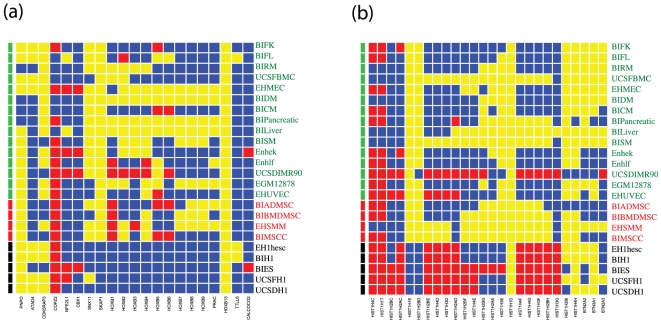
Representative chromatin domains identified by the hidden Markov model.Heatmap of the chromatin state distribution at the local genomic loci. (a) the HOXB gene cluster; (b) The histone gene cluster. Genes are ordered according to their genomic positions. Red – active state; yellow – null state; blue – nonactive state. The cell line information is shown at both sides of the heatmap and color-coded by the differentiation status (black – plutipotent (P) cells; red – multipotent (M); green – unipotent/differentiated (U/D)).